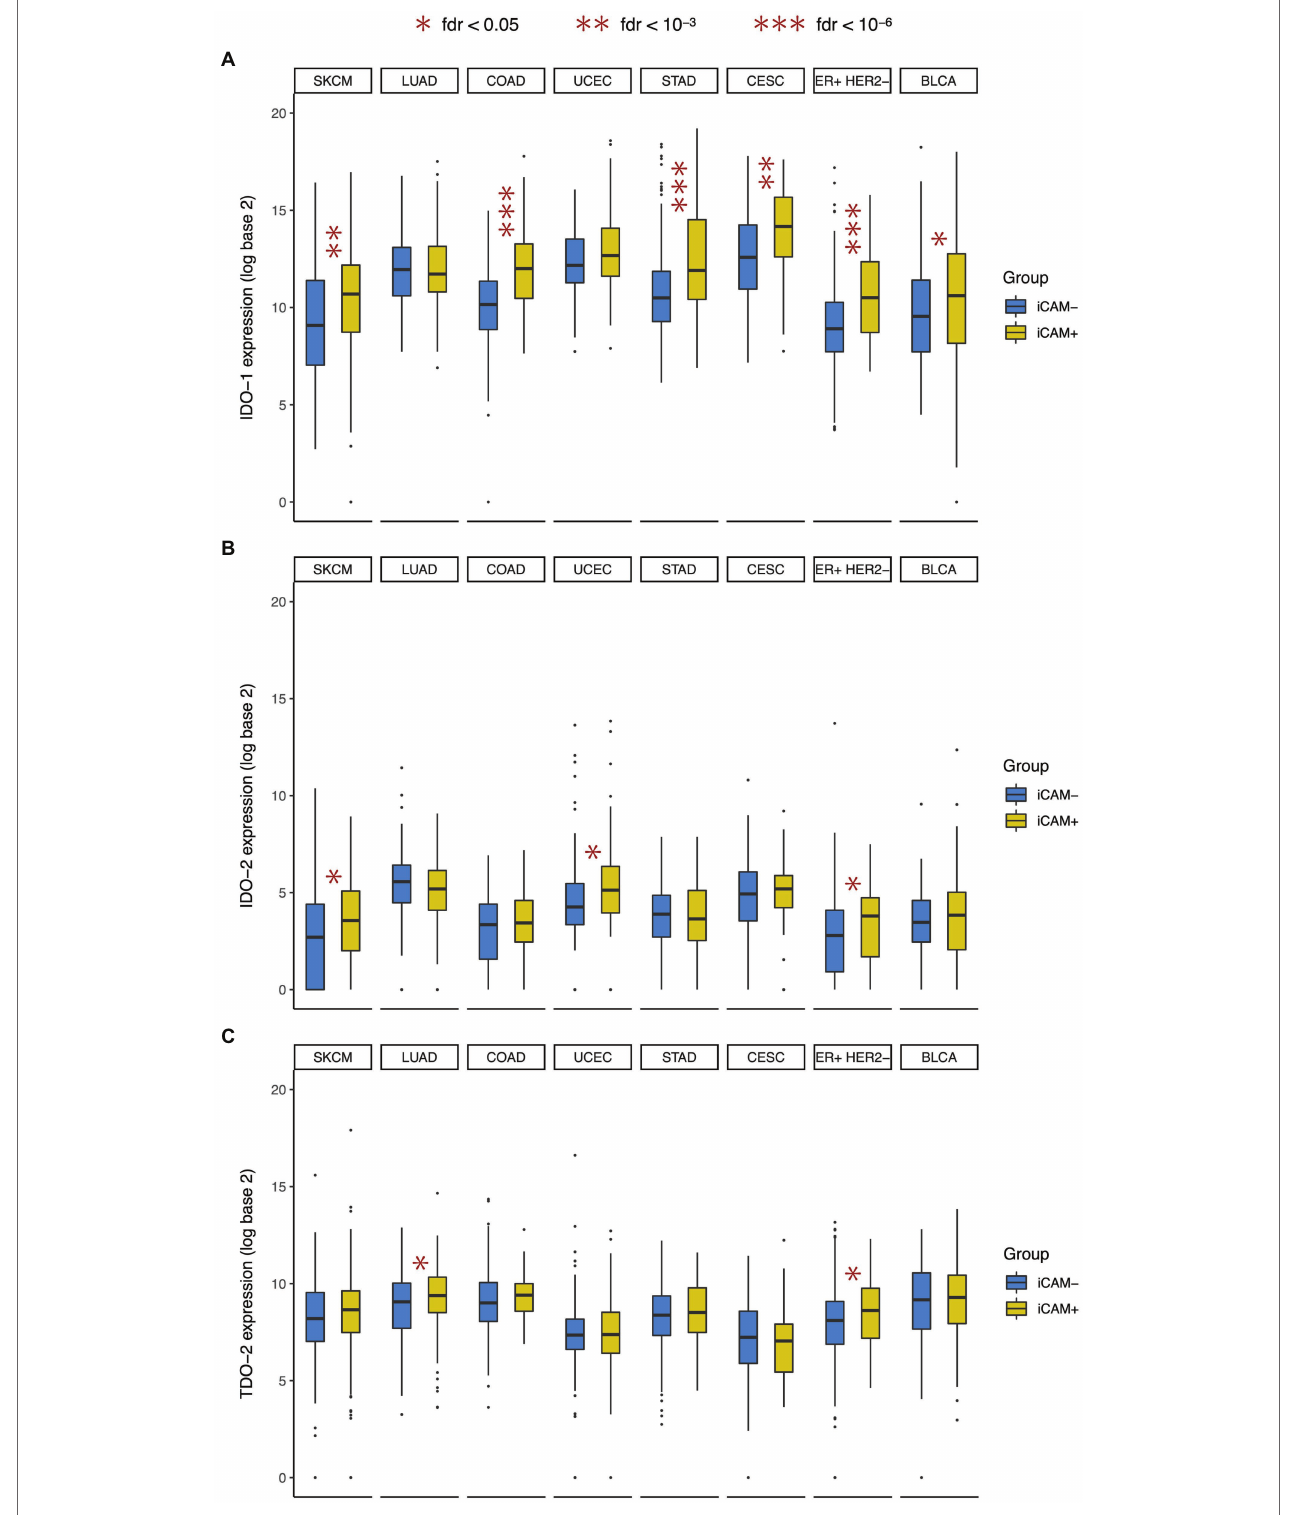
FIGURE 3 | Association between IDO pathway expression and tumor mutational burden. Expression of (A) IDO-1 , (B) IDO-2 , and (C) TDO-2 in high mutation burden (iCAM+) and low mutation burden (iCAM − ) tumors. Cancer type acronyms are standard TCGA abbreviations (https://gdc.cancer.gov/resources-tcga-users/ tcga-code-tables/tcga-study-abbreviations). FDR, false discovery rate. * fdr < 0.05, ** fdr < 10 -3 , and *** fdr < 10 -6